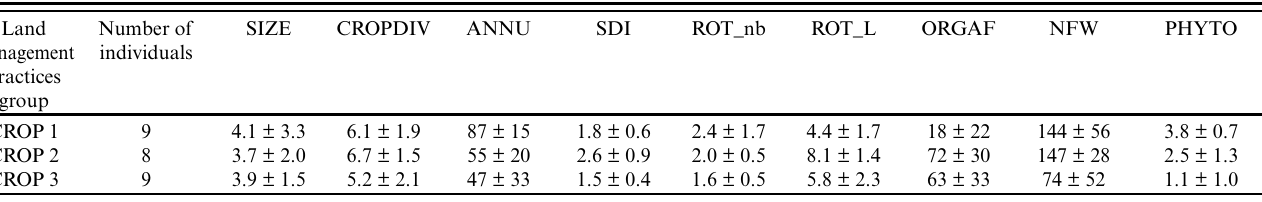
Table 2. Descriptive statistics for the three types of cropland management practices identified for typology 1 (mean ± SD). See Table 1 for definitions of variable codes.